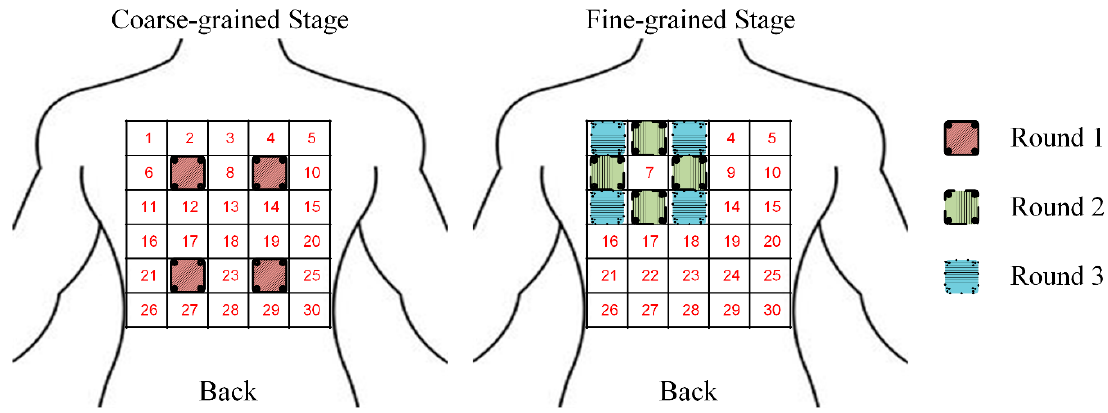
Figure 6. Example of electrocardiography (ECG) investigation using WFEES modules based on L44S method with three rounds.